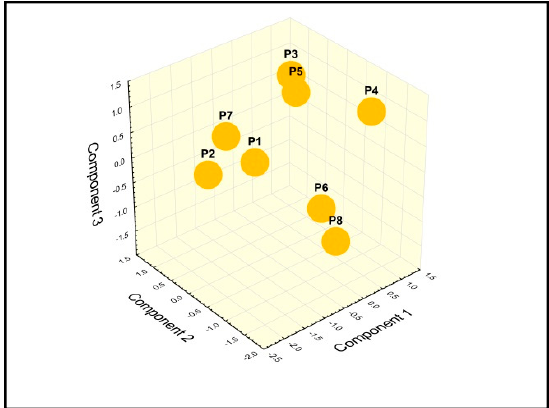
Figure 10. Cluster analysis - projection of the samples on a plane spanned by the three principal components.